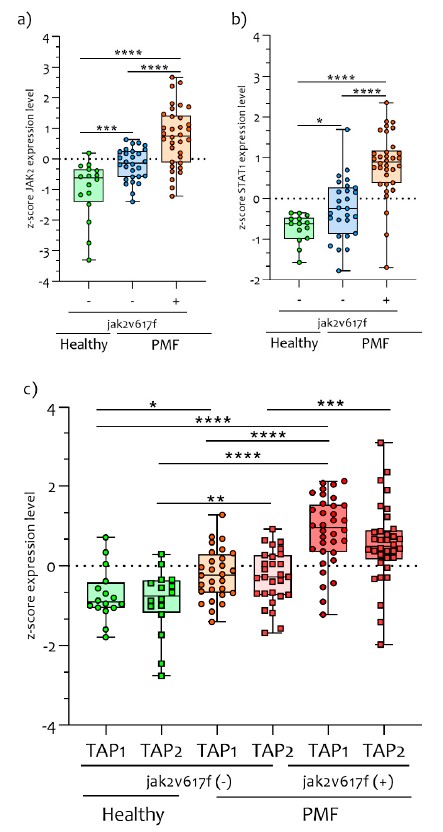
Figure 3. JAK2 / STAT1 and TAPs gene expression levels in PMF patients and healthy control subjects. The JAK2 / STAT1 expression levels are closely linked to the PMF condition. During our analysis, we showed that JAK2 / STAT1 gene expression levels were significantly upregulated in PB CD34 + cells of PMF patients compared to healthy controls subjects ( a and b ). Furthermore, the PMF patients who had the JAK2 V617F mutation had significantly upregulation of JAK2 / STAT1 compared to wild-type. Transporters associated with Antigen Processing 1 and 2 are proteins that in humans are encoded by the TAP1 and TAP2 genes. These genes are involved in the degradation of peptides in order to assemble at the class I molecules. In CD34 + cells of PMF patients, we showed that TAP1 and TAP2 expression levels were significantly upregulated compared to healthy controls subjects ( c ). Furthermore, PMF JAK2 V617F mutated patients presented significantly upregulated levels of TAP1 and TAP2 compared to PMF JAK2 V617F wild-type. Data are expressed as z-score intensity expression levels and presented as vertical scatter dot plots. p values <0.05 were considered to be statistically significant (* p < 0.05; ** p < 0.005; *** p < 0.0005; **** p <